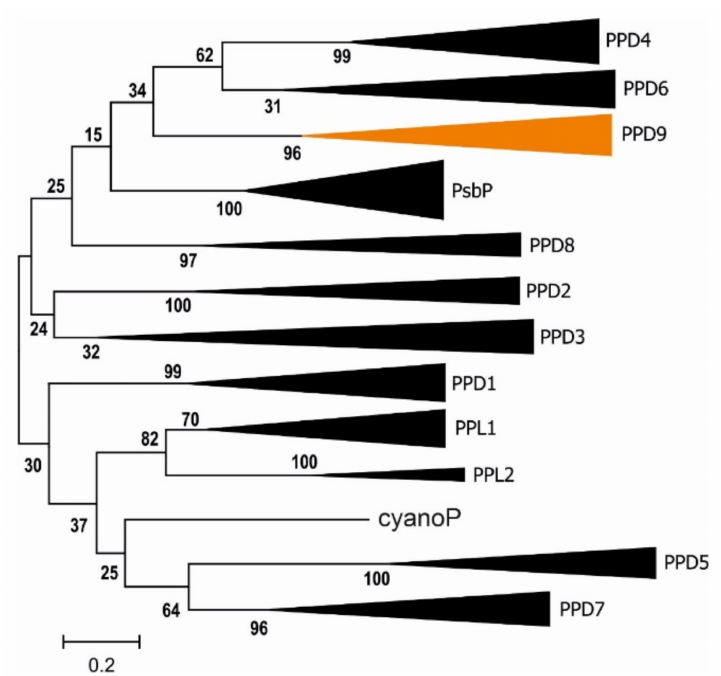
Figure 4. Phylogenetic analysis of PsbP families of 11 photosynthetic organisms. Compressed maximum likelihood tree shows relationships between full length putative PsbP domain-containing proteins isolated from the sequenced genomes of Arabidopsis thaliana , Oryza sativa , Amborella trichopoda , Medicago truncatula , Physcomitrella patens , Marchantia polymorpha , Selaginella moellendorffi , Volvox carteri , Ostreococcus lucimarinus , Chlamydomonas reinhardtii and Synechocystis sp. PCC 6803 (cyanoP; sll1418). Each node except cyanoP contains an orthologous group that is named according to homology with the corresponding PsbP domain-containing protein in Arabidopsis. The node corresponding to the novel PPD9 described here is colored in orange. Numbers show bootstrap values that indicate confidence in branching points. Scale shows substitutions per